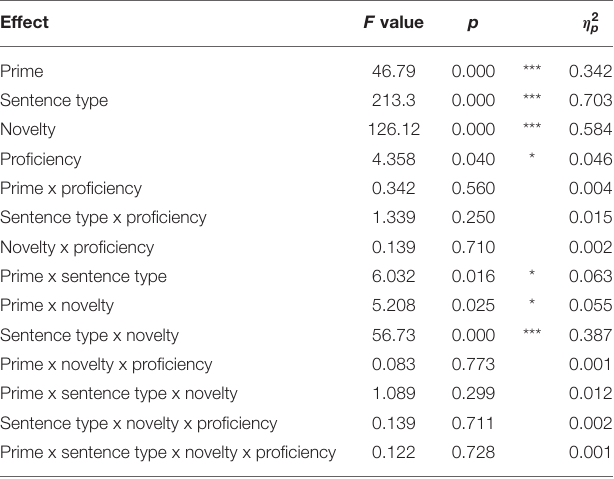
TABLE 5 | Results of four-way ANOVA analysis on RTs.